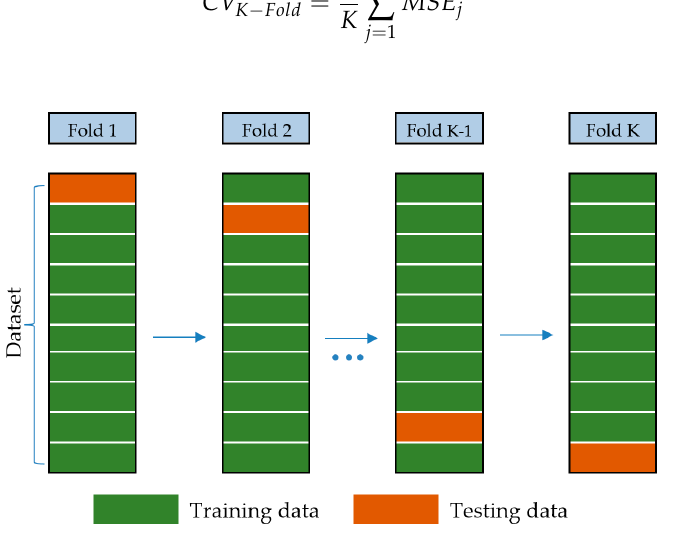
Figure 10. K-Fold Cross-Validation (CV).